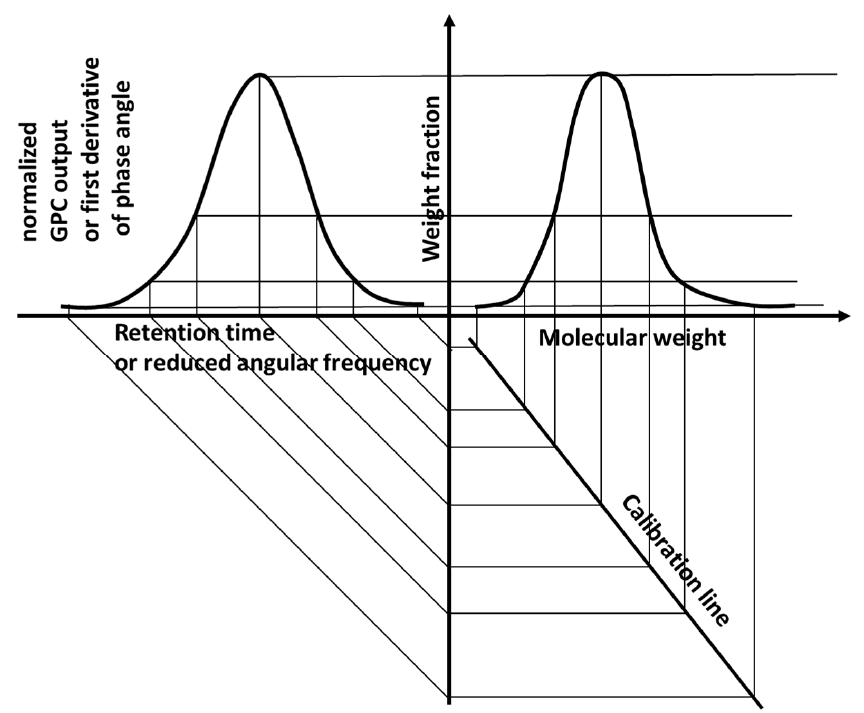
Figure 3. The conversion of the experimental data in an MWD.